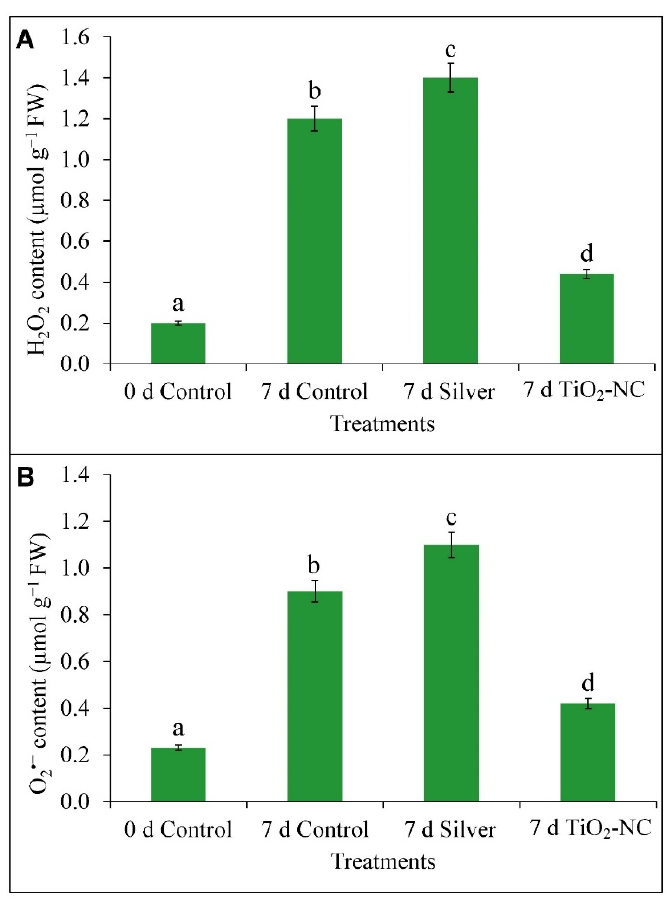
Figure 6. H 2 O 2 content ( A ) and O 2• − content ( B ) of Capsicum fruit recorded under silver and TiO 2 -NC with respect to control during 0 d and 7 d of postharvest storage at 25 °C. Vertical bars showing SE ± 1 ( n = 3) on each column and letters (a, b, c and d) above bars indicate statistical variations between treatments based on one way ANOVA ( p ≤ 0.05).